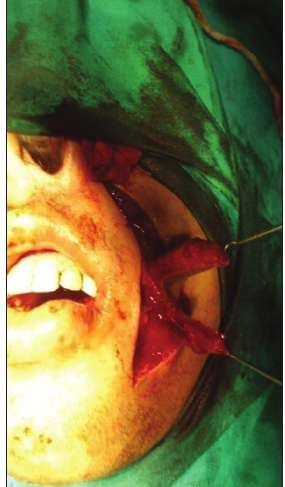
Figure 3: Harvesting of nasolabial flap.